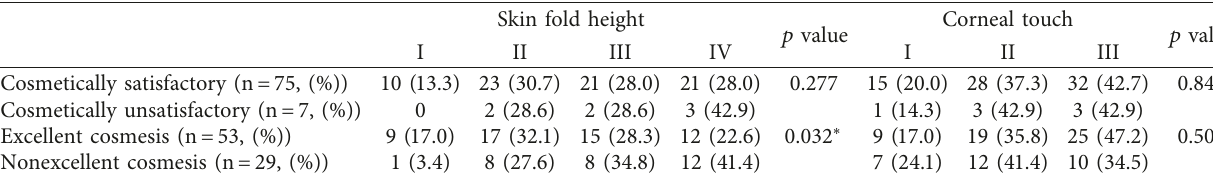
Table 4: Cosmetic satisfactions depending on the skin fold height and cilia-corneal touch. Skin fold